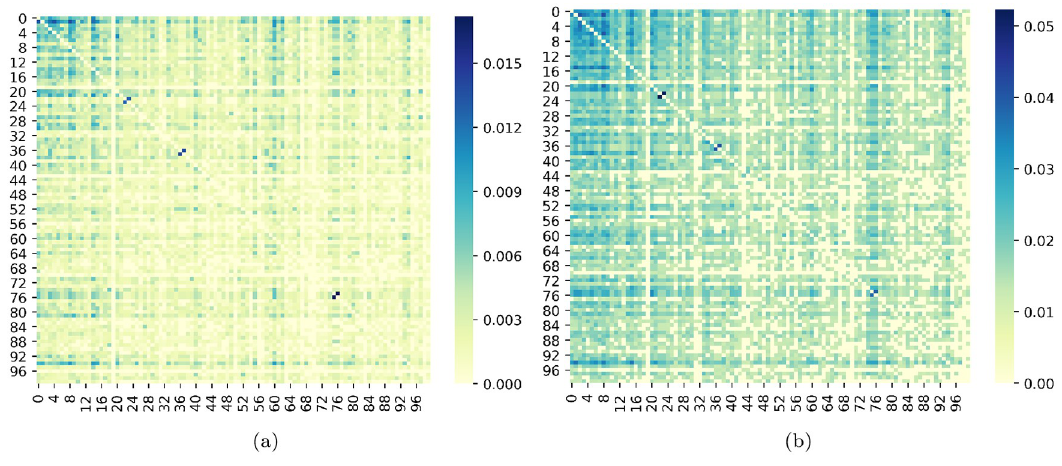
Fig 3. Heat map of STE. (a) m = 2. (b) m = 3. The color intensity represents the magnitude of